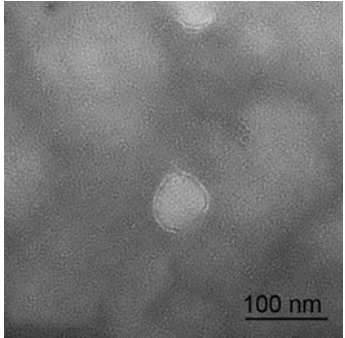
Figure 1. Micrograph of sheep milk extracellular vesicles (EVs).